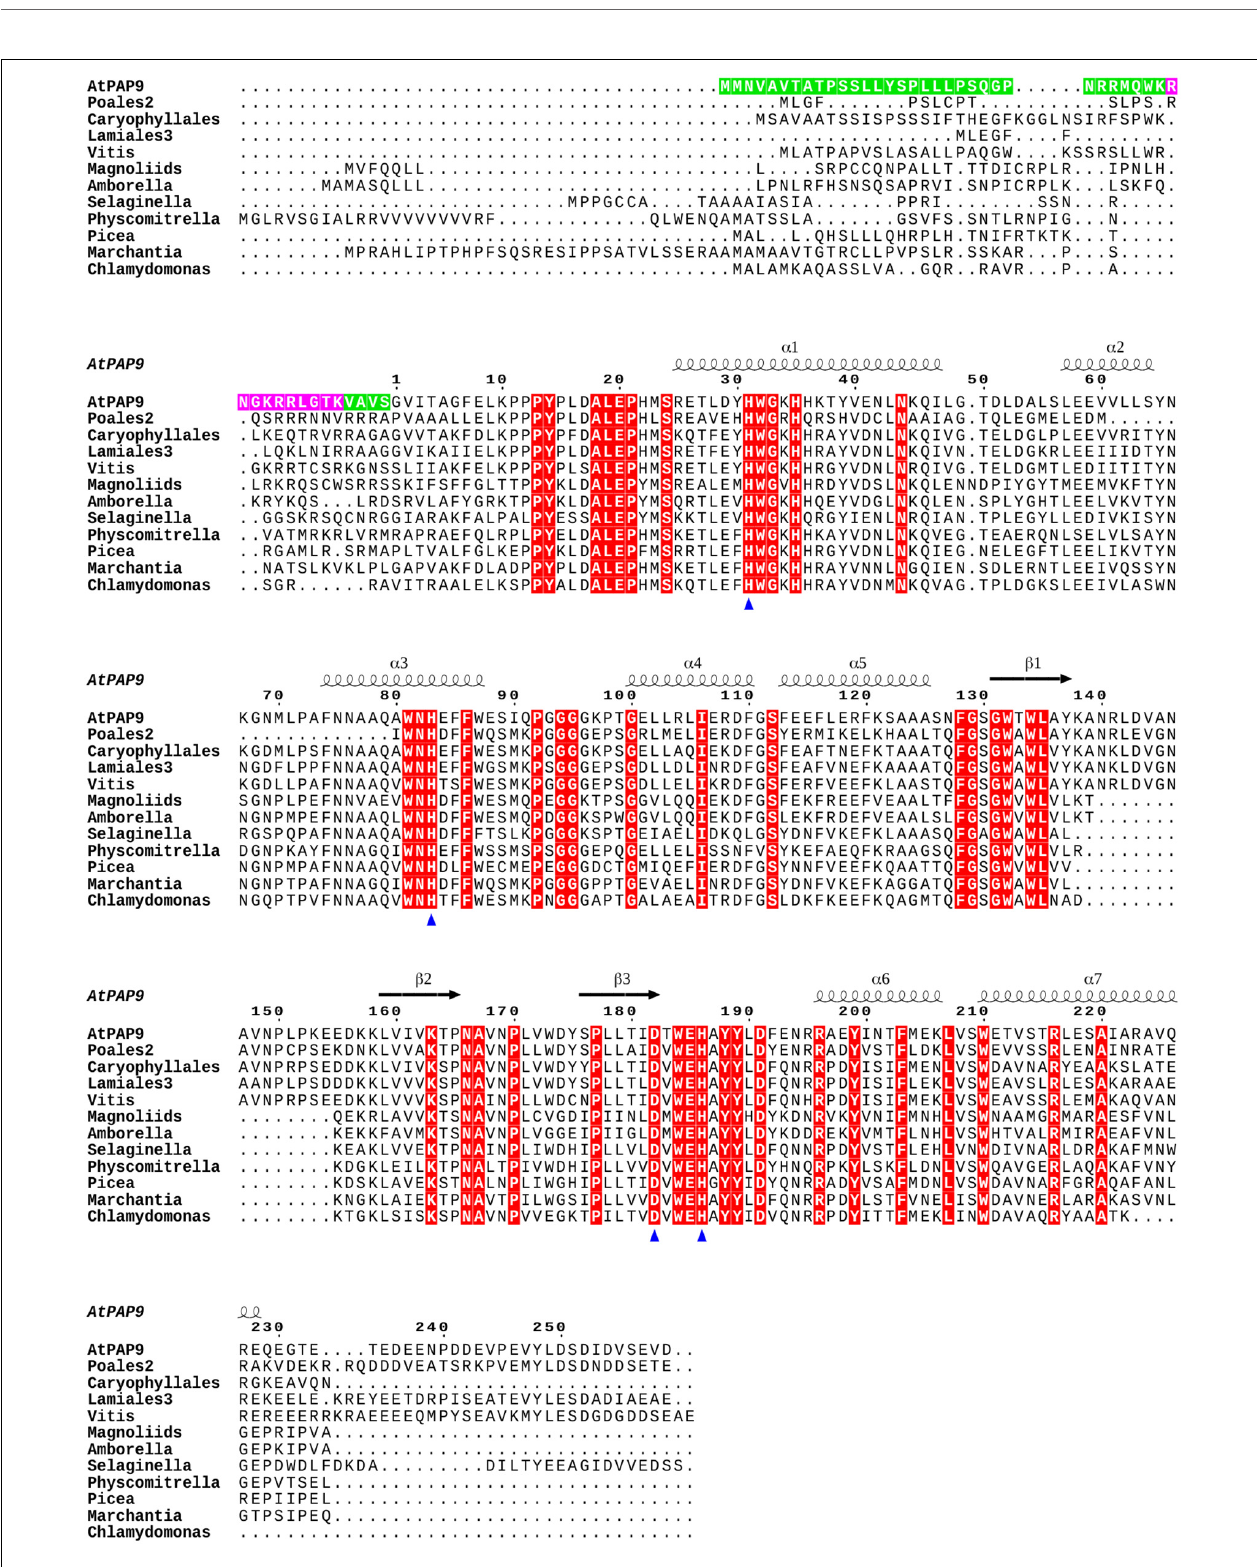
FIGURE 1 | PAP9 secondary structures mapping on a sequence alignment including orthologous proteins from different clades of the green lineage. The PAP9 secondary structure from Arabidopsis thaliana is drawn as followed: the α -helices are displayed as squiggles and β -strands as arrows. The conserved residues are highlighted in red. The residues involved in the metal binding, Zn 2 + in the crystal structure of A. thaliana PAP9, are indicated with a blue triangle. The cTP and NLS of the A. thaliana PAP9 are highlighted in green and magenta, respectively. The drawing was prepared using ESPript (Robert and Gouët, 2014).